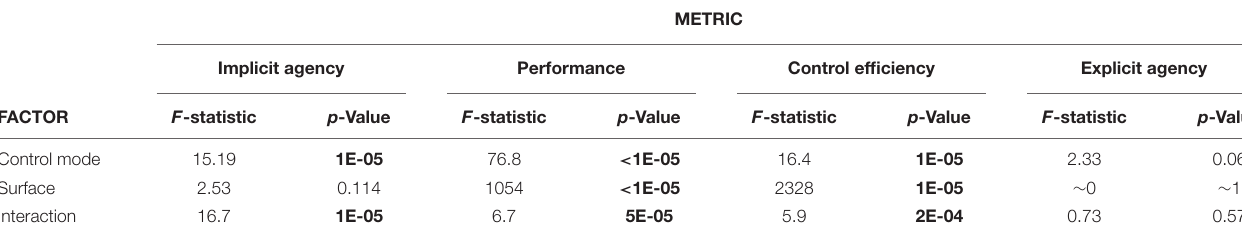
TABLE 2 | Two-way ANOVA results for each metric over factors of control mode and